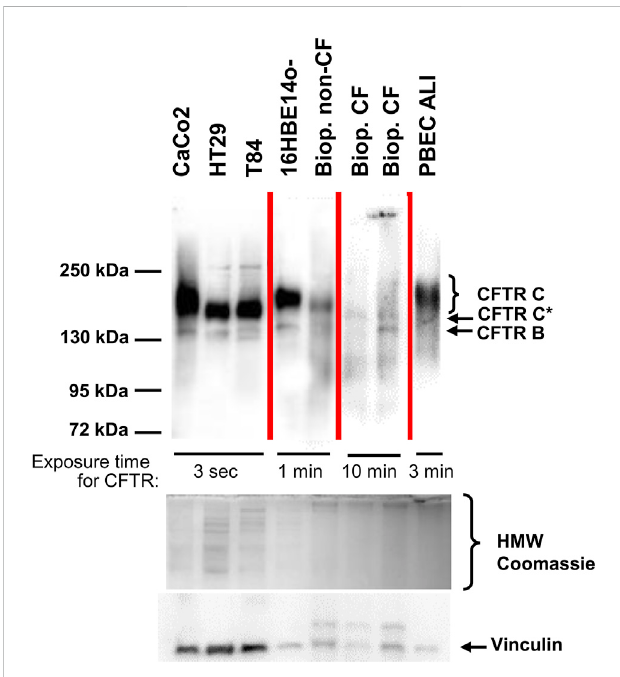
FIGURE 1 CFTRimmunoblotanalysesofepithelialcelllines,primarybronchial epitheliumandfromrectalbiopsiesfromonehealthycontrolandtwoCF samples. CFTRsignals wereobtained fromtheintestinalcancer cell lines CaCo2, HT29,T84,fromtheimmortalizedrespiratoryepithelialcell line 16HBE14o-, from primary peripheral bronchial epithelium (PBEC) generated by air-liquid interface (ALI) culture and compared to a rectal suction biopsy derived from anon-CF control ( “ Biop. non-CF ” )and from twoCFrectalsuction biopsies( “ Biop.CF ” ).Westernblotsreveal anarrow bandBat130 kDaandamuchbroaderbandCbetween150and180 kDa in all samples except for the CF patients ’ biopsies. Rectal biopsies from CF patients showed a band B similar to the other samples and generated a narrow signal, migrating slower than band B at approximately 140 kDa designated as CFTR C*. A poly-disperse wild-type band C visible in all other non-CF samples was absent from CF biopsies. Samples were loadedononegel,yetthis fi gureisacompositeasvisualizationofsignals was done using exposure times between 3 s and 10 min for CFTR as noted within the fi gure. Source data of all four exposures of the